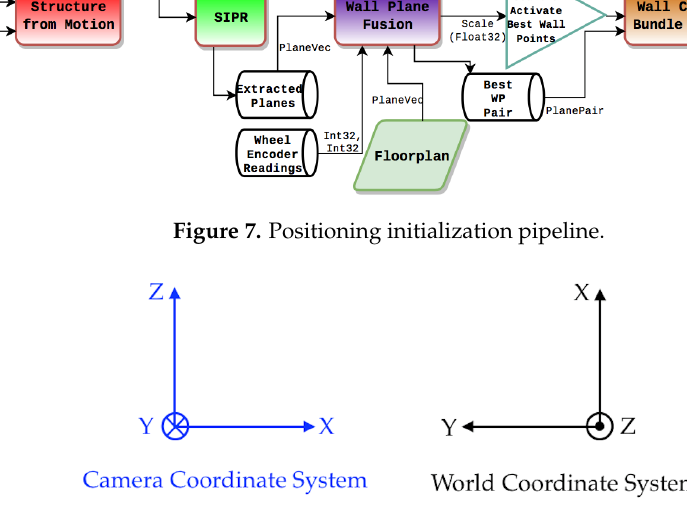
Figure 8. Coordinate systems—Top View; see